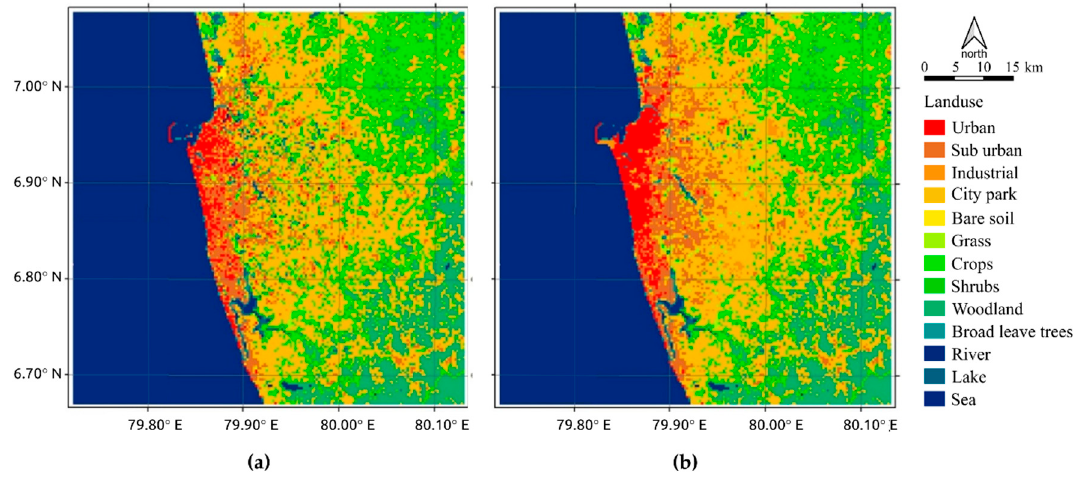
Figure 2. Land-cover map of ( a ) 1997; and ( b ) 2015.